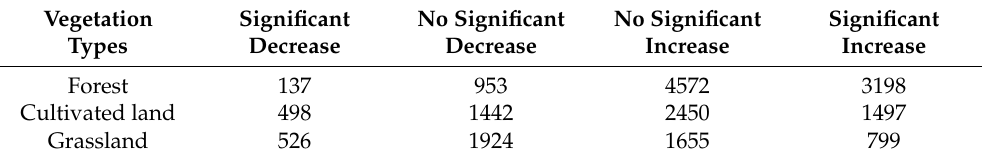
Table 6. Pixel numbers containing different trends in EOS of three vegetation types of northeast China for 1982–2014 (5% significance level).